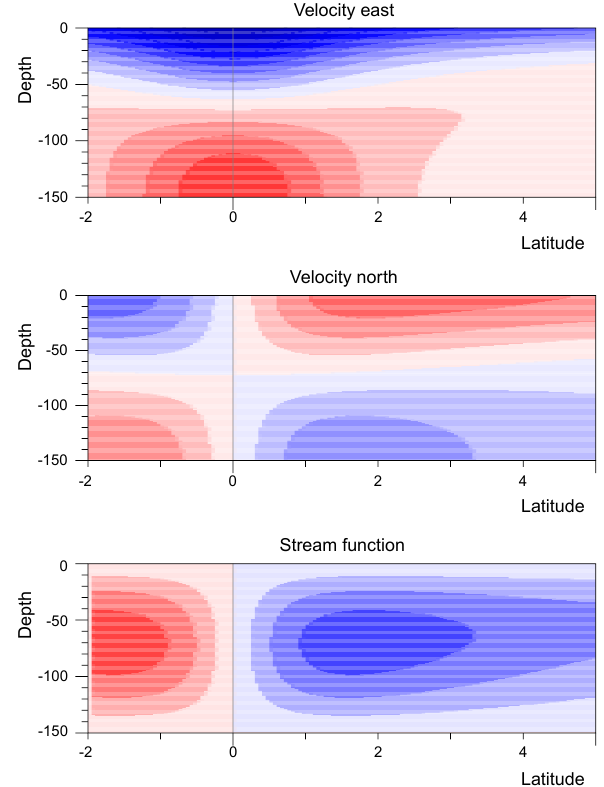
Figure 8. Solution of Stommel’s model of the tropical cell, for a sur- face layer 150m deep, of constant density and with a vertical kine- matic viscosity of 100cm 2 s − 1 (Webb, 2018). Velocity contours are at intervals of 5cms − 1 . Stream function contours are at intervals of 2m 2 s − 1 . Positive values are in